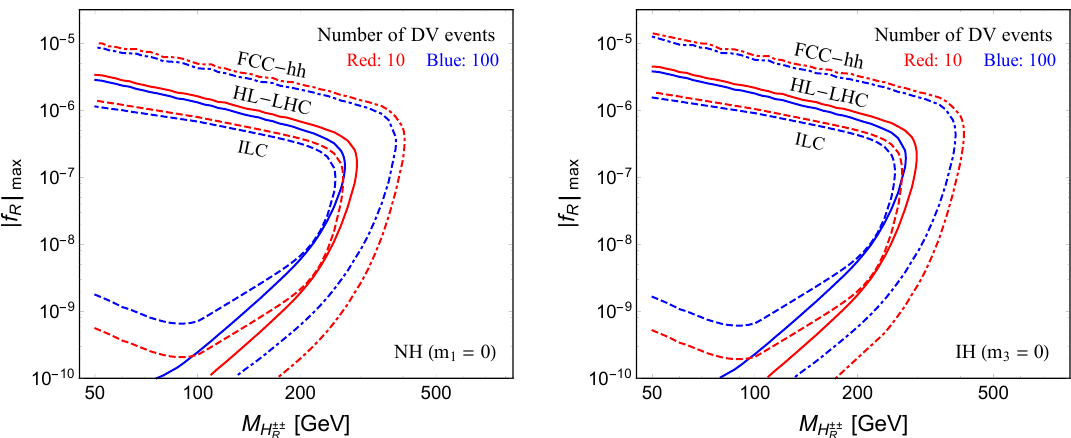
Figure 19 . DV prospects from the decay of H (cid:6)(cid:6) ! e (cid:6) e (cid:6) ; e (cid:6) (cid:22) (cid:6) ; (cid:22) (cid:6) (cid:22) (cid:6) in the LRSM, at HL-LHC R 14 TeV with an integrated luminosity of 3000 fb (cid:0) 1 (solid contours), the 100 TeV collider FCC-hh with a luminosity of 30 ab (cid:0) 1 (dot-dashed contours) and ILC 1 TeV with 1 ab (cid:0) 1 (dashed contours). The red and blue contours respectively correspond to 10 and 100 DV events, as functions of M H (cid:6)(cid:6) R and the largest Yukawa coupling j f R j max , for the neutrino spectra of NH (left) and IH (right) with lightest neutrino mass m 0 =